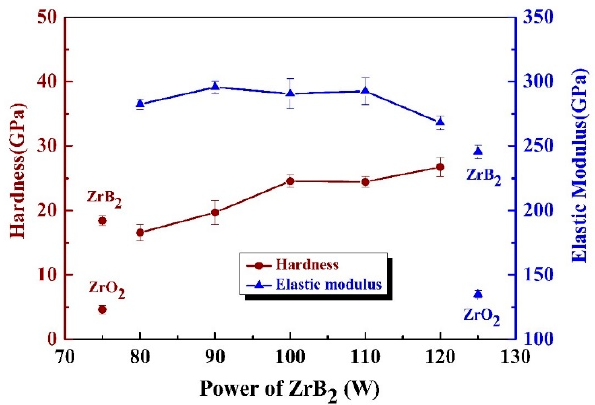
Figure 5. Hardness and elastic modulus of ZrB 2 , ZrO 2 monolayers, and Zr-B-O nanocomposite films at di ff erent sputtering powers of the ZrB 2 target.